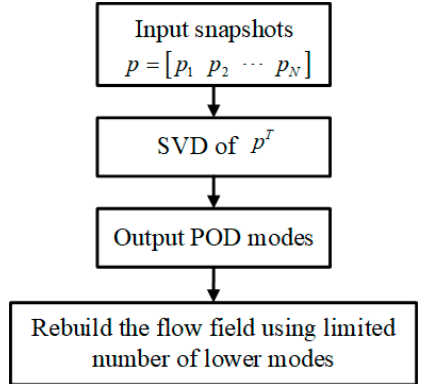
Figure 6. Detailed process of proper orthogonal decomposition (POD).